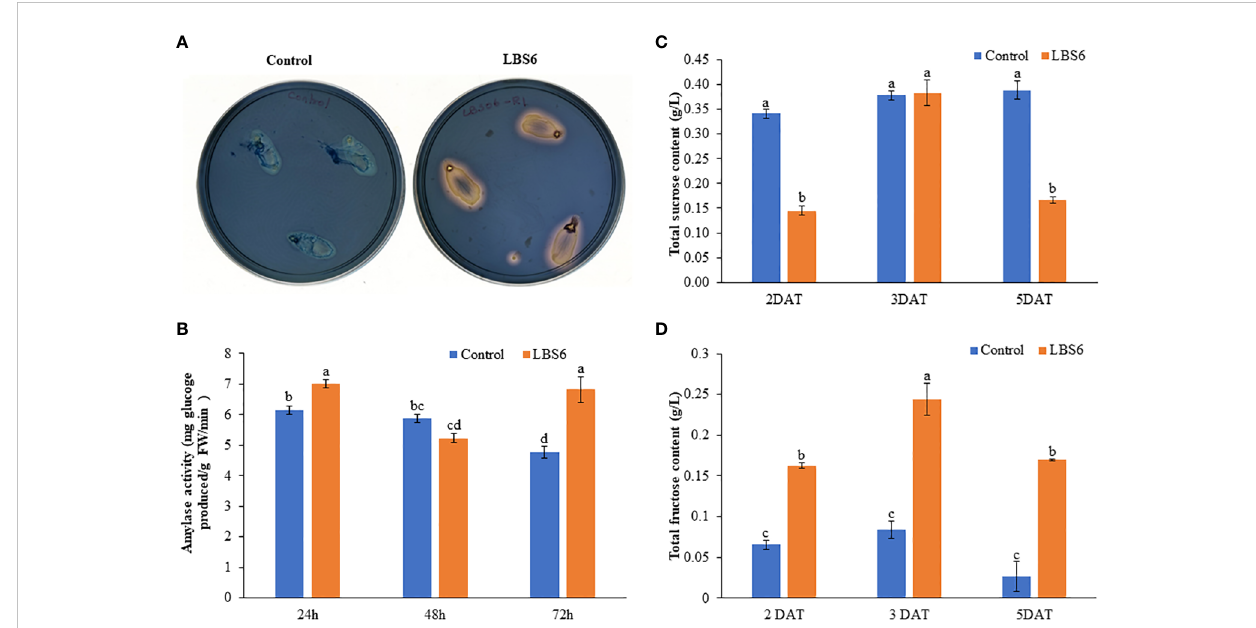
(Figure 4A). Twenty-four hours after treatment, expression of APC10 was 2.8 times higher in those LBS6-treated cotyledons than the control (Figure 4B). No signi fi cant difference in the expression of CDC123 (cell division cycle protein 123 homolog) was observed 24 h after treatment, whilst at 48 h there was a